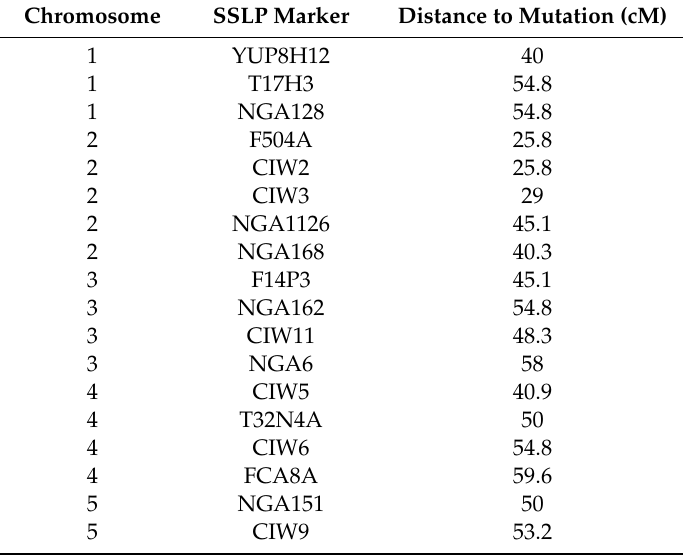
Table 4. Marker-assisted mapping of ewe2